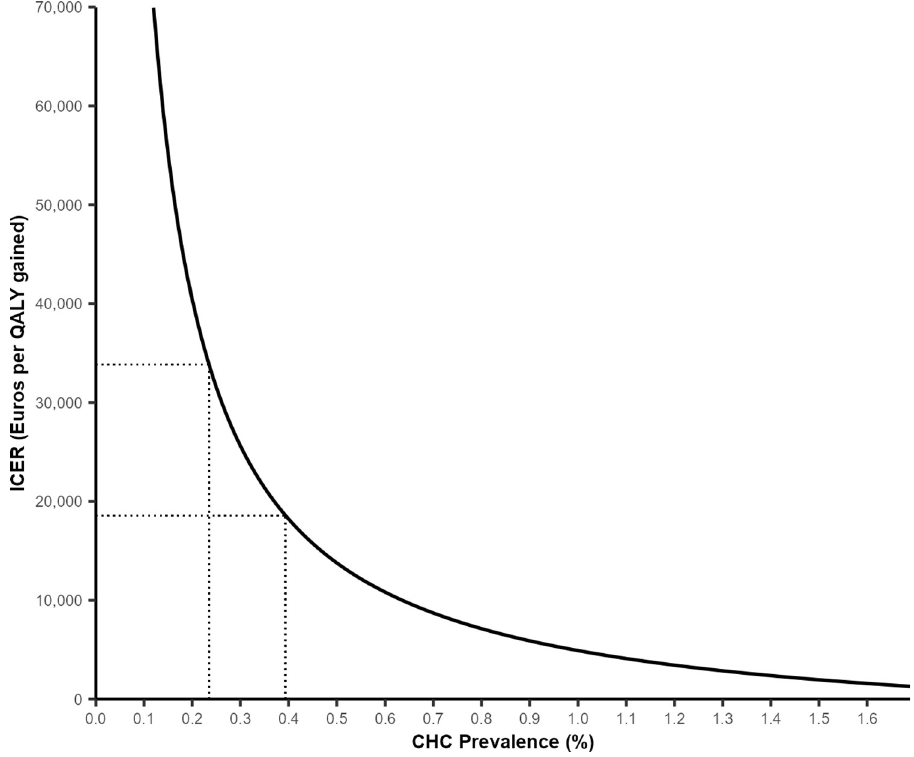
Fig 2. Threshold analysis. Dotted lines indicate WTP thresholds of € 18,592 and € 33,817. https://doi.org/10.1371/journal.pgph.0001559.g002 Probabilistic sensitivity analysis. The intervention was likely to be cost-effective in the base case analysis. At the WTP thresholds of € 18,592 and € 33,817, testing was cost-effective in 70% and 82% of simulations ( Fig 4 ). The mean probabilistic ICER was € 4,070, which is slightly